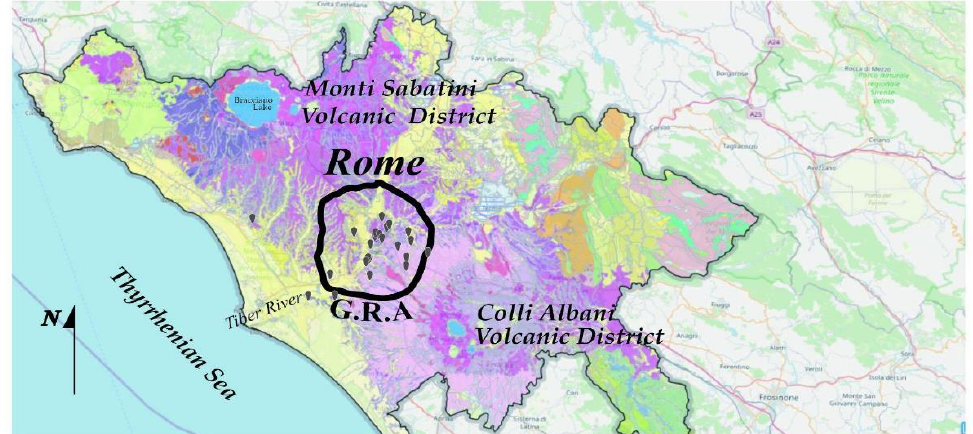
Figure 1. Geologic map of Rome and municipalities of the metropolitan area; the legend is provided at https://g3w-suite.cittametropolitanaroma.it/it/map/dati-territoriali/qdjango/66/ (accessed on 25 July 2022). Deposits from Monti Sabatini Volcanic District crop out north of Rome, and deposits from Colli Albani Volcanic District crop out south and east of the city. Gray pins refer to the houses monitored in our experiments; the black circle represents the “Grande Raccordo Anulare,” the ring-shaped motorway that encircles Rome.